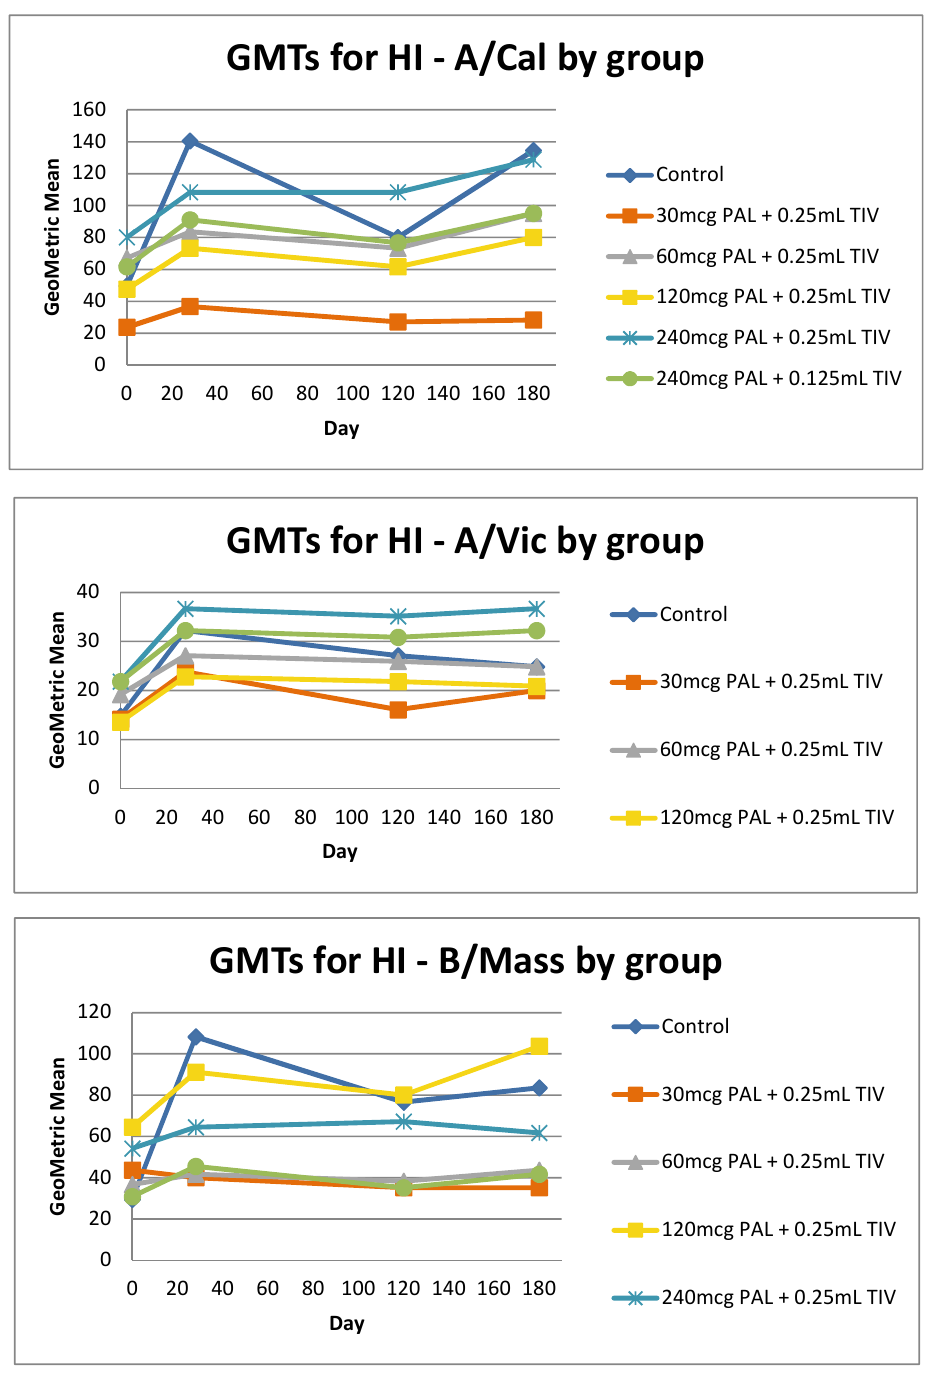
Figure 3. Haemagglutinin Inhibition (HI) Geometric Mean Titers (GMT) to PAL-adjuvanted Trivalent seasonal influenza vaccine (TIV) from Day 0 to 180 in healthy young adults. Legend. A/California – Influenza A/California/7/2009 (H1N1) pdm-like virus, A/Victoria-Influenza A/Victoria/361/2011, B/Mass-B/Massachusetts/2/2012-like virus. Note, after day 120 participants were free to be vaccinated with the seasonal influenza vaccine as recommended by local public health authorities.